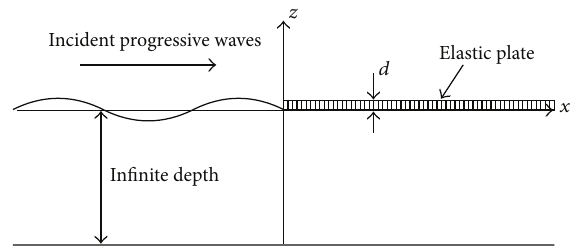
Figure 1: Schematic diagram for the interaction between incident progressive waves and a semi-infinite elastic plate floating on a fluid of infinite